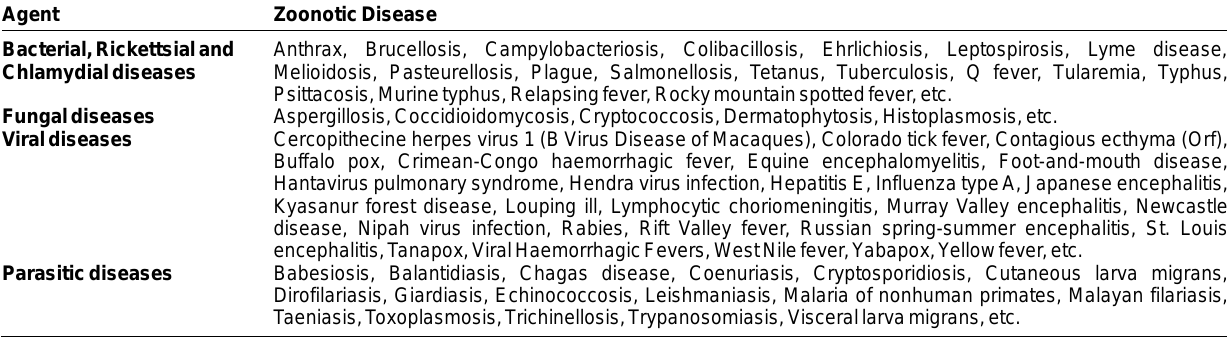
Table-2. Zoonotic diseases transmitted from different categories of wild animals [Source: 19,25] Species